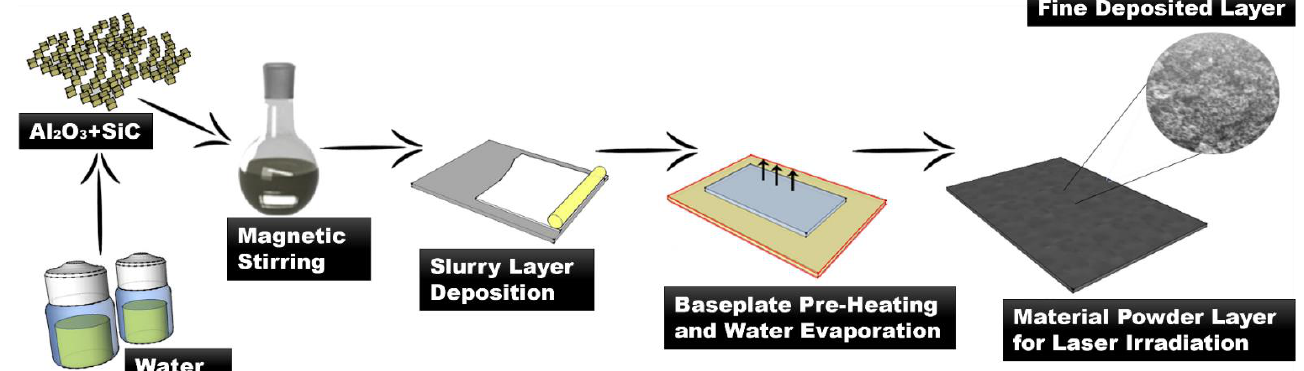
Figure 1. Layer deposition method.